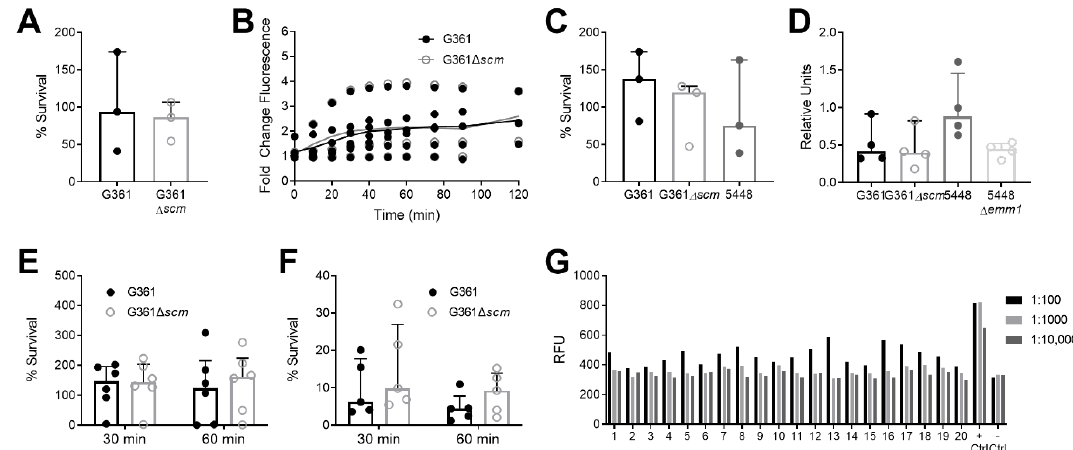
Figure 2. SCM does not alter S. canis survival, reactive oxygen species release, cytokine production, nor induce antigenic activity in human sera. ( A ) Percent survival of S. canis G361 or G361 ∆ scm after 30 min of exposure to canine DH82 macrophages, MOI = 1. ( B ) Reactive oxygen species production by DH82 macrophages infected with S. canis G361 or G361 ∆ scm, MOI = 10, and normalized to uninfected cells. ( C ) Percent survival of S. canis G361 or G361 ∆ scm after 30 min of exposure to human THP-1 differentiated macrophages, MOI = 1. ( D ) THP-1 cells were infected with S. canis G361 or G361 ∆ scm, MOI = 1, and cell supernatant added to HEK-Blue cells. Alkaline phosphatase activity was measured colorimetrically at OD620 and background signal (uninfected cell supernatant) was deducted. Fold IL-1 β release was calculated versus GAS across four independent experiments. ( E ) Percent survival of S. canis G361 or G361 ∆ scm after 30 or 60 min of infection in human whole blood. ( F ) Percent survival of S. canis G361 or G361 ∆ scm after 30 or 60 min of infection in isolated human neutrophils, MOI = 1. ( G ) Quantification of human IgG titers, expressed as relative fluorescent units (RFU), for a purified truncated form of SCM ( n = 20 donors) via modified ELISA using diluted human sera, positive control: recombinant human IgG, negative control: buffer only. Symbols represent independent experimental replicates ( A – D ), biological replicates (( E ), n = 6/group, ( F ), n = 5/group), or the results of one independent experiment ( G ), performed twice independently), with lines indicating medians and interquartile ranges. Data were analyzed by Wilcoxon matched-pairs signed rank test ( A ), two-way ANOVA with Sidak’s multiple comparisons post-test ( B , E , F ), or Friedman test with Dunn’s multiple comparisons test ( C , D ) and determined not significant.